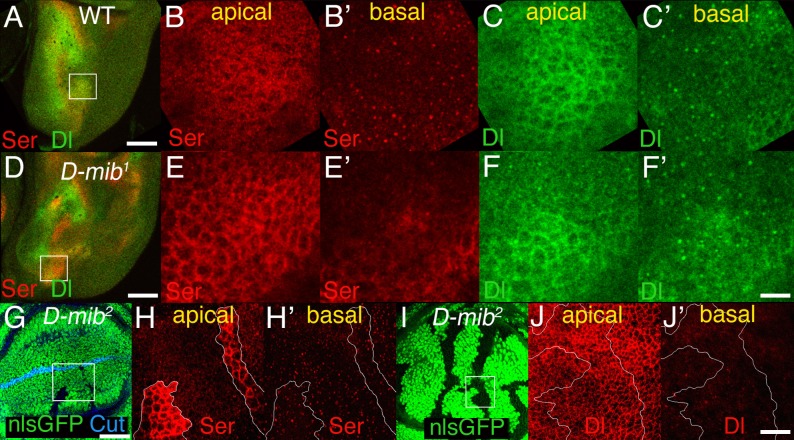
D-mib Is Required to Down-Regulate Ser at the Apical Cortex(A–F′) Distribution of Dl (green) and Ser (red) in the notum region of wild-type (A–C′) and D-mib1 mutant (D–F′) wing imaginal discs. The boxed areas in (A) and (D) are shown at higher magnification in (B–F′). The specific loss of Ser accumulation into intracellular vesicles (compare [E′] with [B′]) correlated with the elevated levels of Ser seen at the apical cortex of D-mib mutant cells (compare [E] with [B]).(G–J′) Ser (red in [H and H′]) accumulated at the apical cortex (H) as well as in intracellular dots (H′) in D-mib2 mutant cells (marked by the loss of nuclear GFP; green in [G]). Cut is shown in blue (G). The distribution of Dl (red in [J and J′]) was not affected by the loss of D-mib activity. Low-magnification views of the wing portion of the discs are shown in (G) and (I). (H and H′) and (J and J′) show high magnification views of the areas boxed in (G) and (I), respectively. Clone boundaries are outlined in (H and H′) and (J and J′).Bar is 40 μm for (A, D, G), 5 μm for (B–C′ and E–F′), and 10 μm for (H–J′).